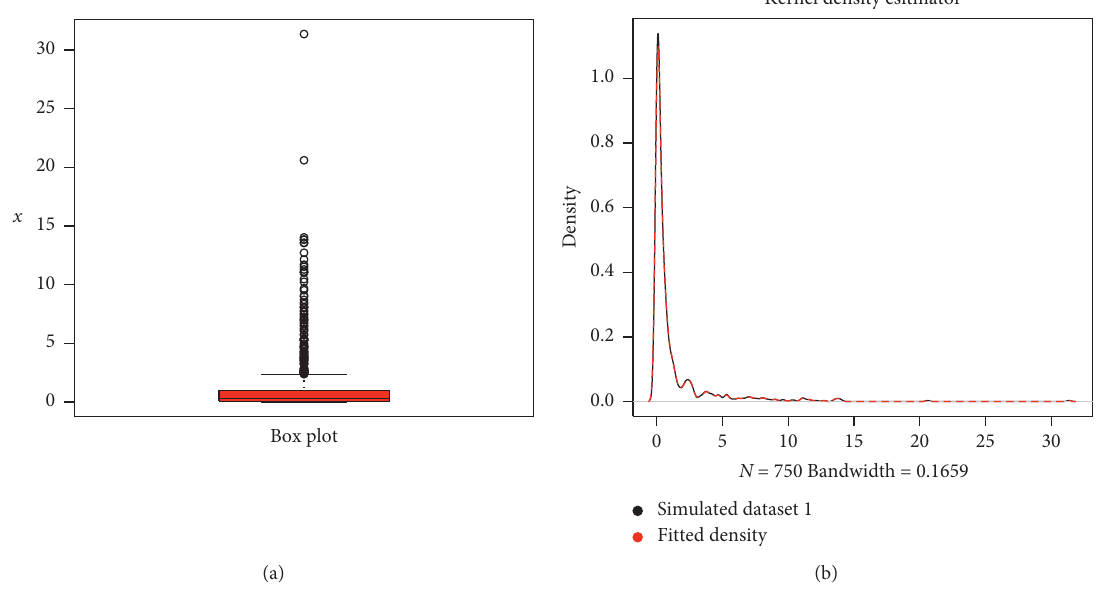
Figure 8: Box plot and Kernel density estimator plot of the simulated dataset 1.